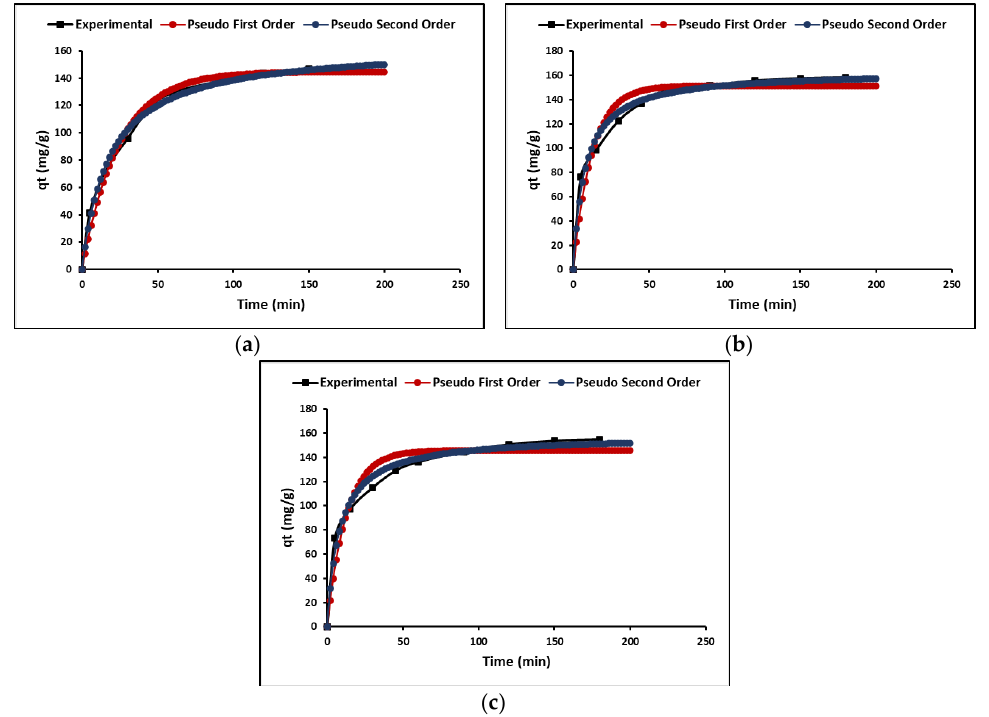
Figure 7. Adsorption kinetics of ( a ) ZTO, ( b ) La/ZTO, and ( c ) Ce/ZTO. Since the adsorption rate is determined by the transfer rate of the adsorbate from the solution to the adsorption sites of the adsorbent, the intraparticle diffusion model was also used to describe the nonequilibrium stage of adsorption. Figure 8 shows the variation over time (t 1/2 ) of the qt (mg g − 1 ) curves for the ZTO, La/ZTO, and Ce/ZTO nanoparticles.